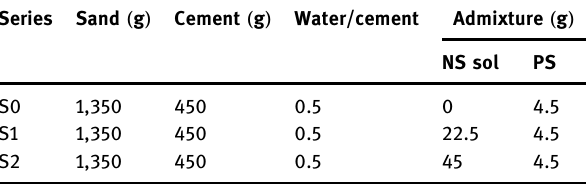
Table 3: Mix proportions of di ff erent specimens Series Sand ( g ) Cement ( g )